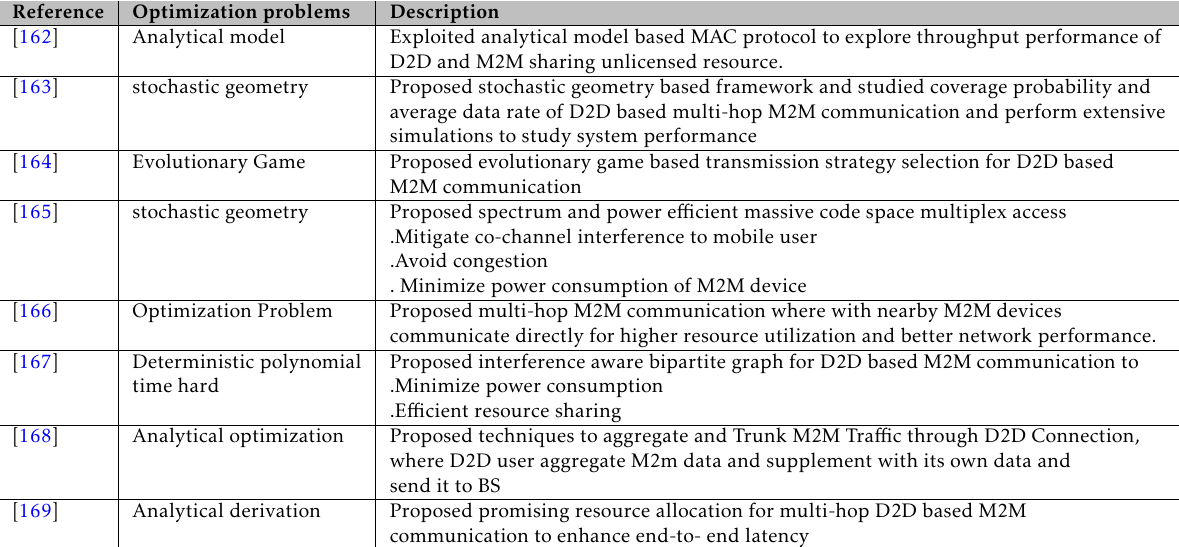
Table 9. Resource Optimization for D2D-based M2M